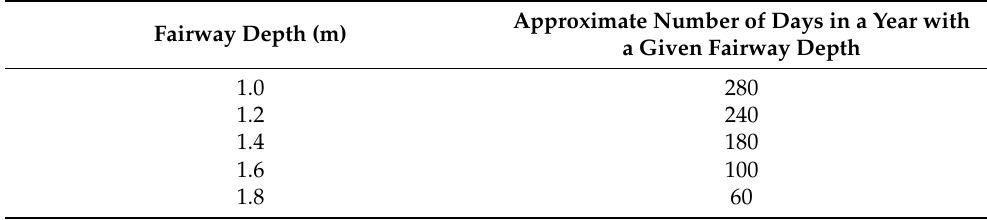
Table 2. Fairway depths on the Vistula section from Włocławek to the Gdansk Bay in 2019–2021. Fairway Depth